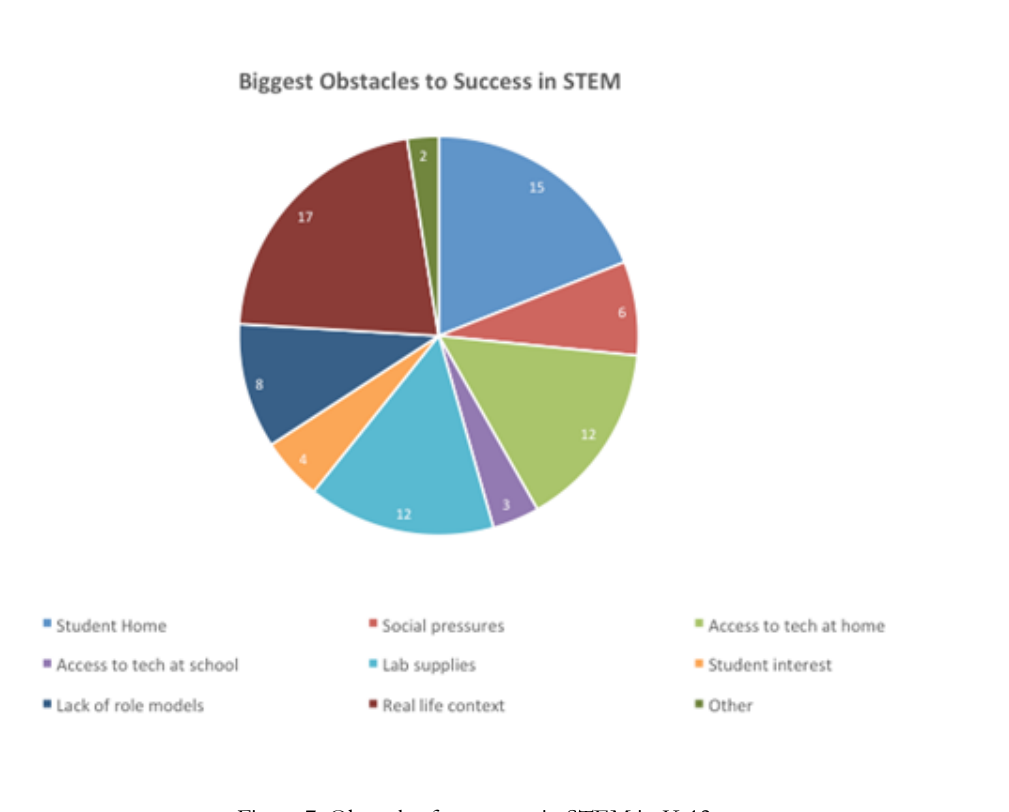
Figure 7. Obstacles for success in STEM in